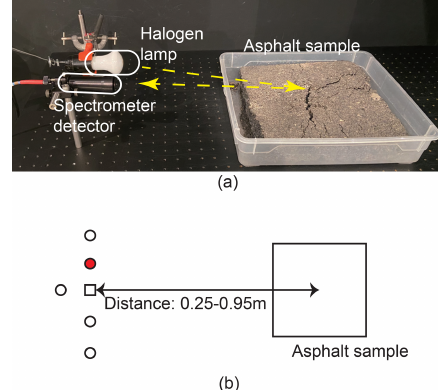
Figure 3. (a) Picture of the experimental setup. (b) Top view sketch of experimental setup. The square represents the position of the spectrometer detector. The circles represent the different positions of the halogen lamp which were tested. For example, the configura- tion of (a) is equivalent to the case for which the source is positioned on the red circle.